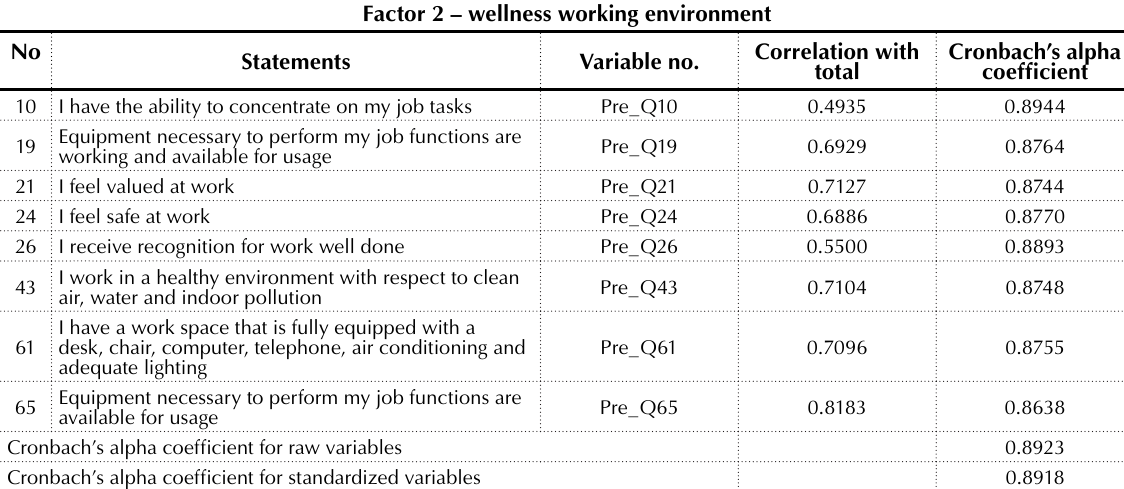
Table 1. Cronbach’s alpha coefficient for employee wellness factor 2: wellness working